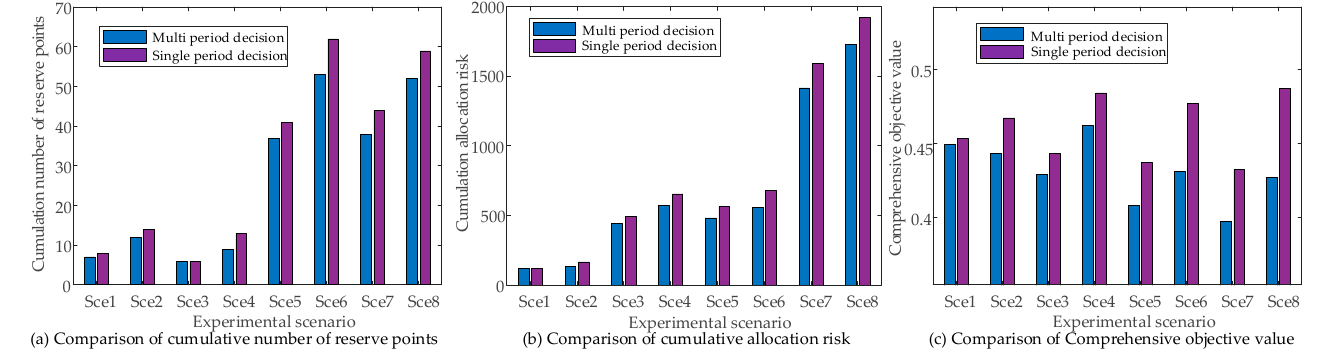
Figure 10. Comparison of allocation schemes with different decision making methods.